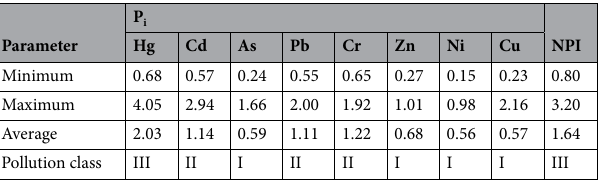
Table 6. Ecological risk of heavy metals in the surface soil within the research